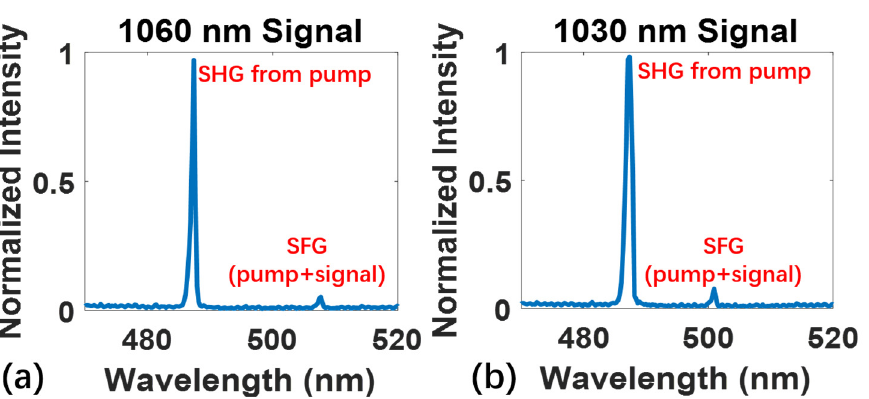
Figure 6. The spectral details of nonlinear frequency conversion from the signal light at ( a ) 1060 nm and ( b ) 1030 nm and the pump light at 976 nm.